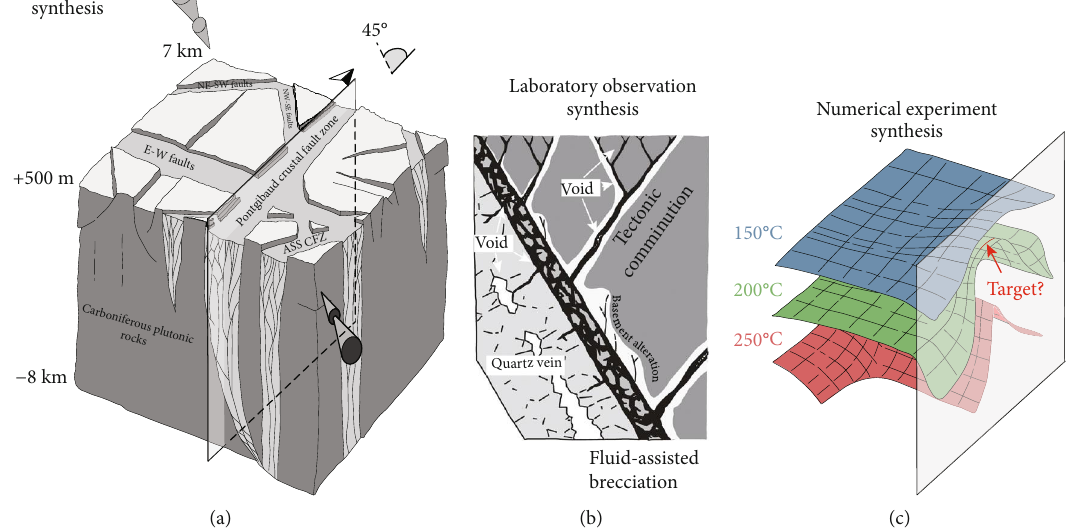
Figure 14: (a) Three-dimensional conceptual model of the Pontgibaud CFZ as a geothermal reservoir potential. Details of the voids present at di ff erent scales and in which fl uids can fl ow. (b) The procceses that may be at the origin of these voids (tectonic comminution, fl uid-assisted brecciation, and basement alteration) are illustrated. (c) Comparison of the large-scale modeling results with fi eld data shows that fl uids could fl ow through a blob-like convective pattern and locate the 150 ° C isotherm at 2.3km